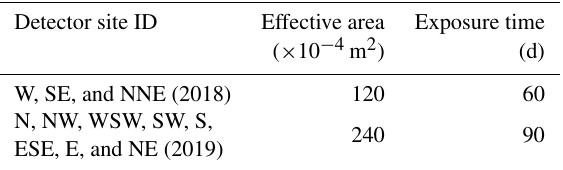
Figure 4. Topography of the Izu–Omuroyama scoria cone. White dots represent observation sites. Table 1. Effective area and muon exposure time for each